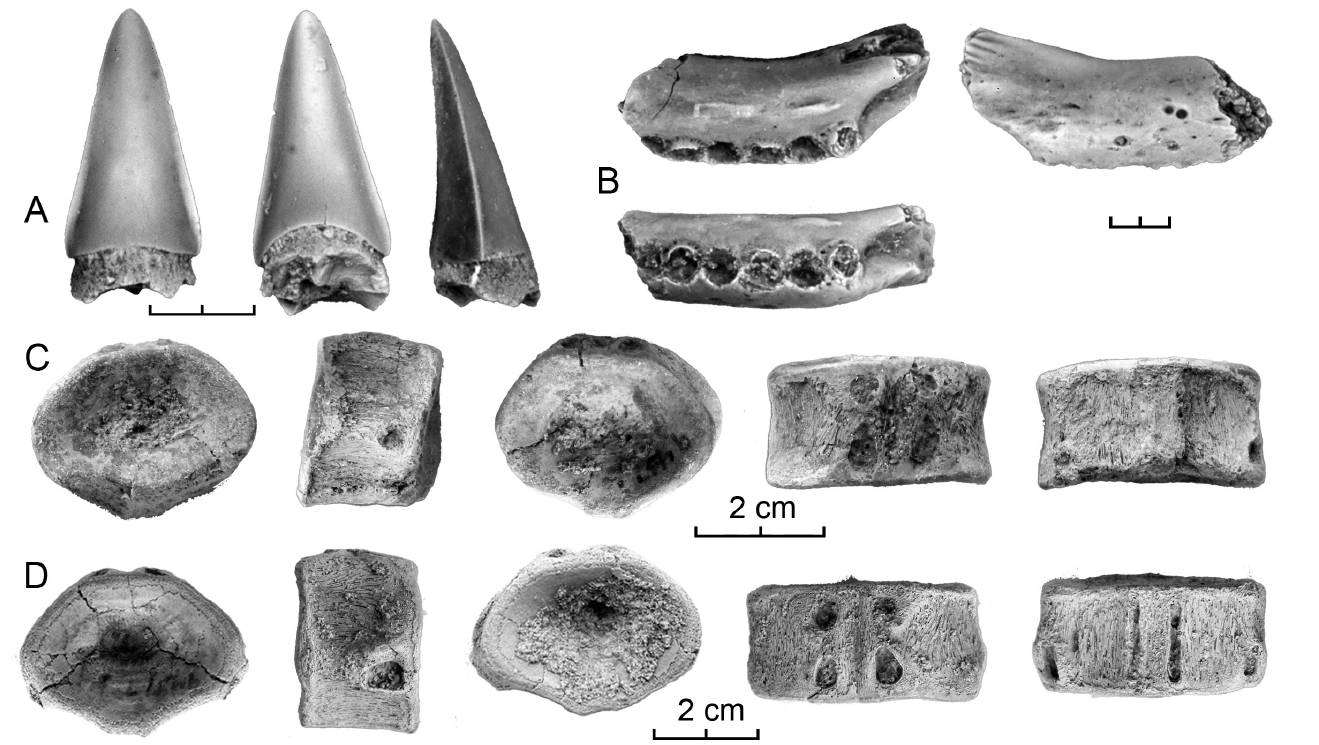
Figure 5. Cf. Melvius elements from the Milk River Formation. A) cf. Melvius tooth in three views, TMP 2000.2.8. B) max - illa fragment referred to cf. Melvius on the basis of the presence of round tooth-bases just touching adjacent teeth, TMP 2000.1.23. C – D) precaudal centra, both included in TMP 94.377.14. Scale bar for A and B equals 2